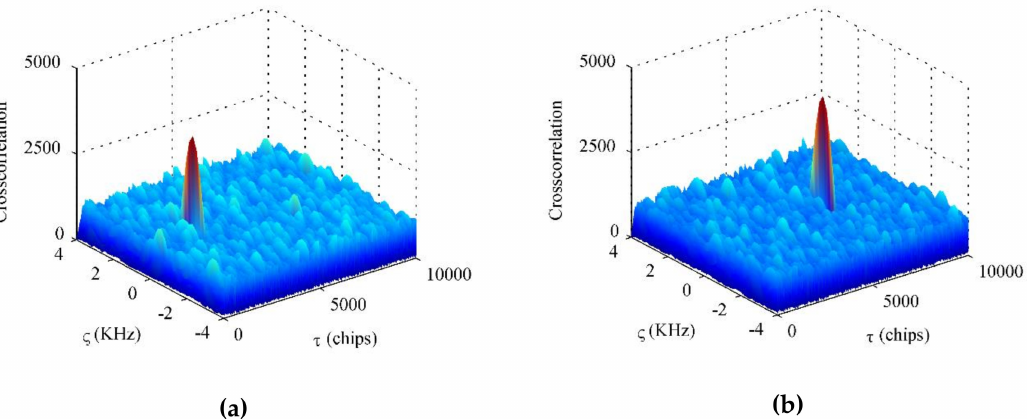
Figure 9. Acquisition results corresponding to the desired BD2 satellites using the proposed STPAP beamforming algorithm: ( a ) PRN 1; ( b ) PRN